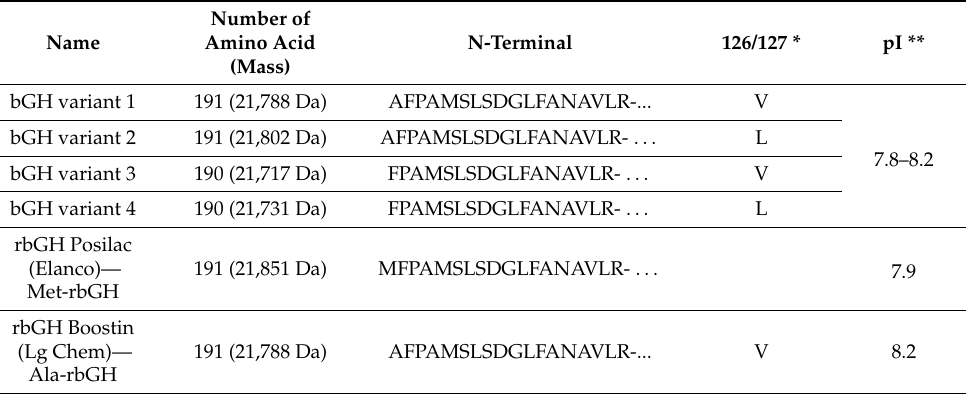
Table 1. Endogenous and recombinant bovine growth hormone characteristics (* the bGH shows heterogeneity at position 127 with either a valine or a leucine due to allelic polymorphism. The majority form is Ala-Phe with Leu at position 127 (variant 2 in the Table)) (** from